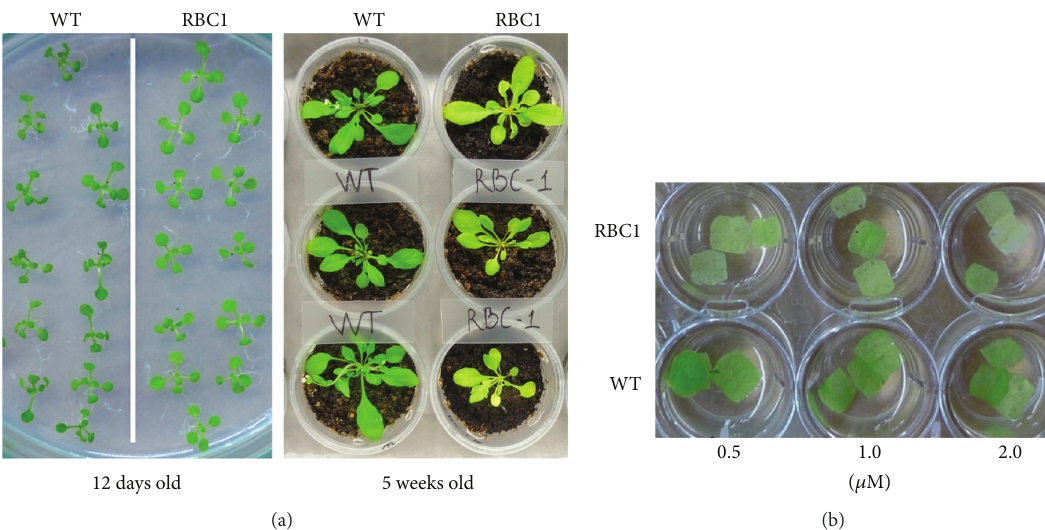
Figure3:Phenotypesofan Arabidopsis overexpressedageneencodingaMRPundernormalphysiologicalcondition(a)andunderaparaquat leaf disc assay (b). WT, wild type control; RBC1, Arabidopsis plant overexpressed At3g55240